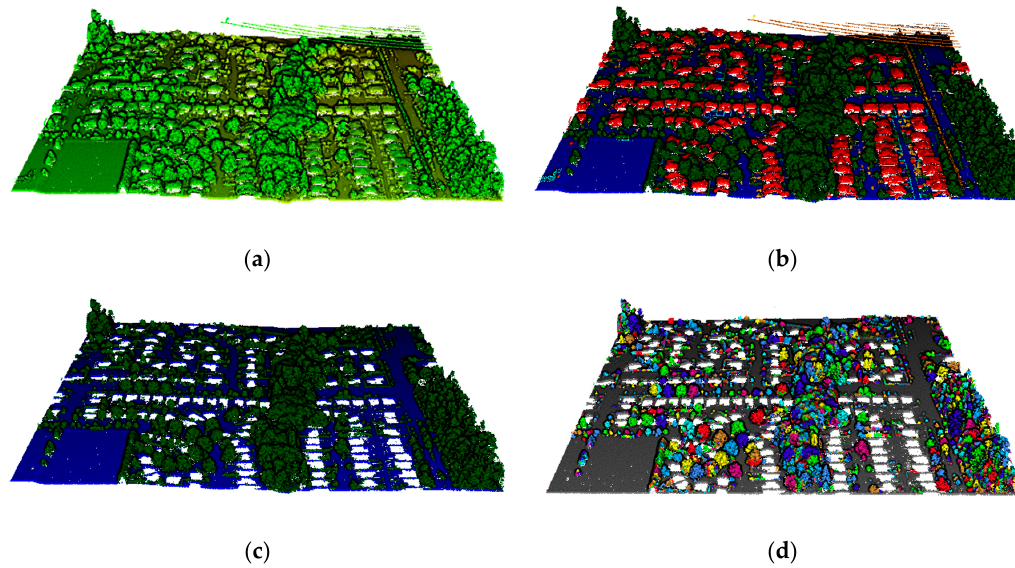
Figure 14. Detailed results from selected area 2 of DALES dataset. ( a ) the original point clouds; ( b ) the classification result; ( c ) the roadside trees extraction; ( d ) the roadside trees segmentation.